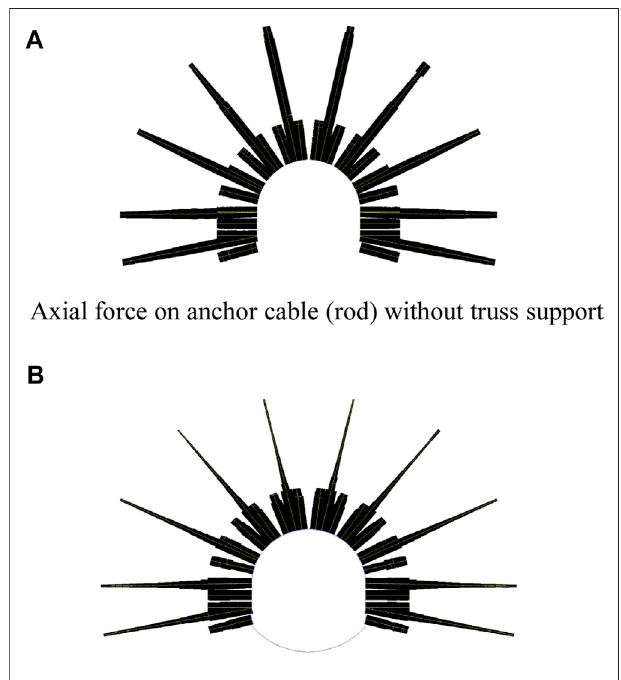
FIGURE 16 | Axial force on the front and rear anchor cables supported bytruss. (A) Axialforceontheanchorcable(rod)withoutthetrusssupport. (B) Axial force of the anchor cable (rod) after truss